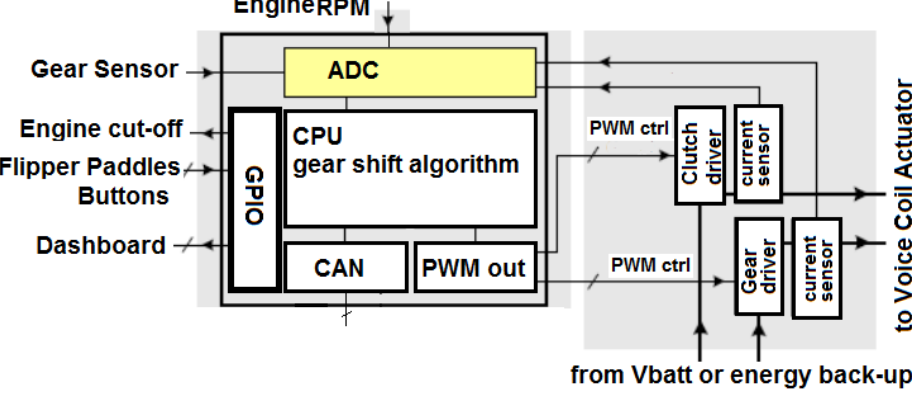
Figure 7. Example application of the actuator control unit (ACU) for robotized gearbox control.